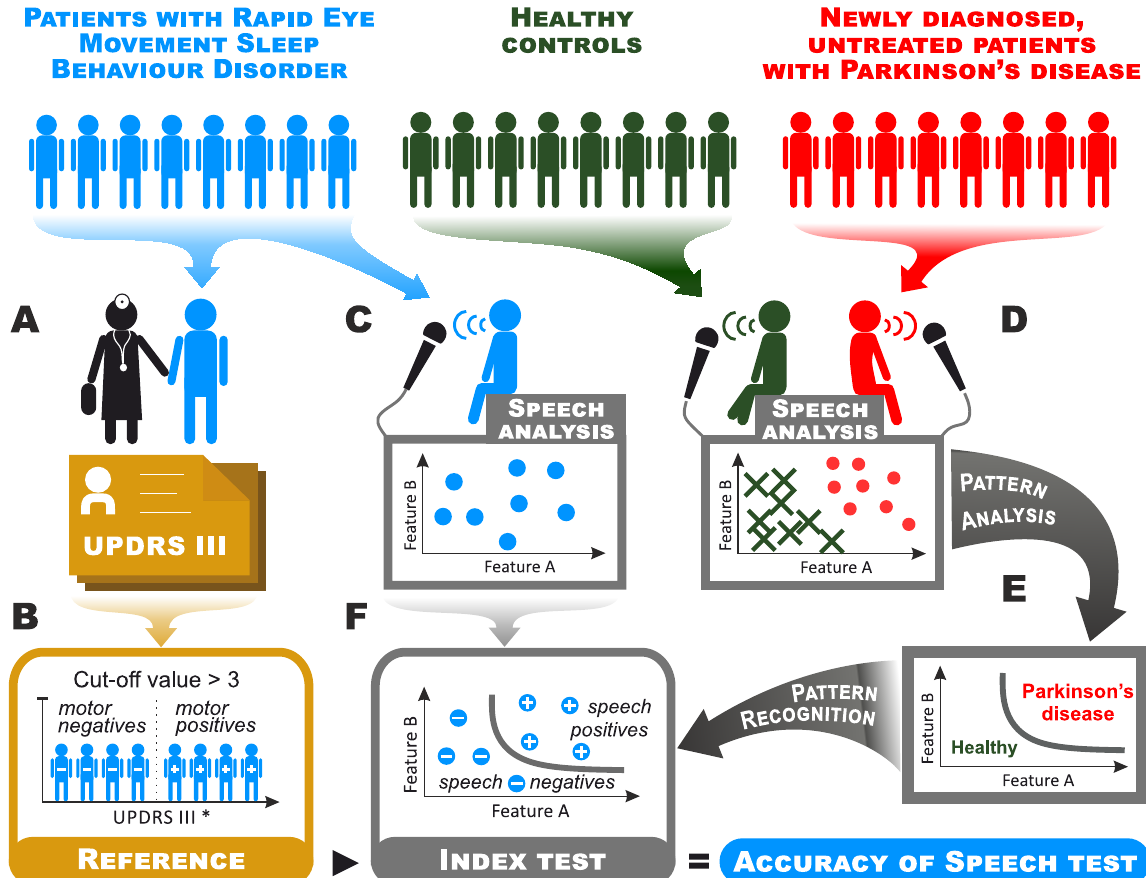
Figure 4. Flowchart describing the procedure of speech test experiment. ( A ) The motor score of UPDRS was examined in each RBD subject by a well-trained neurologist. ( B ) RBD subjects were separated into a subgroup of motor negatives (asymptomatic, UPDRS III * ≤ 3) and a subgroup of motor positives (symptomatic, UPDRS III * > 3). ( C,D ) Speech performances of all newly diagnosed, untreated PD patients, RBD subjects, and controls were analyzed using the set of designed speech features. ( E ) The most distinctive parkinsonian speech patterns were determined as the best resulting combination of speech features for differentiating between newly diagnosed, untreated PD patients and controls. ( F ) All RBD subjects were separated into a subgroup of speech positives (subjects with unchanged speech performance) and a subgroup of speech negatives (subjects with speech performance closer to PD speakers) based on the most distinctive parkinsonian speech pattern obtained through comparison between newly diagnosed, untreated PD and controls. PD = Parkinson’s disease, RBD = rapid eye movement sleep behaviour disorder, UPDRS = Unified Parkinson’s Disease Rating Scale; UPDRS III * = motor part of the UPDRS III score after removal of action